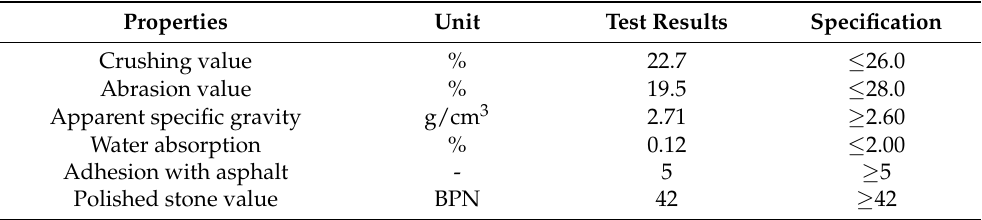
Figure 2. Structure of the low-temperature splitting test specimens. The lower layer was formed according to the Chinese specification for Standard Test Methods of Bitumen and Bituminous Mixtures for Highway Engineering (JTG E20-2011). The upper layer was made on the surface of the lower layer after it had been horizontally placed for 12 h. After demolding, each group of specimens was obtained. 2.2.2. Test Process The low-temperature splitting test was carried out on specimens with different UML thicknesses and control group specimens according to the Chinese specification for Standard Test Methods of Bitumen and Bituminous Mixtures for Highway Engineering (JTG E20-2011). Control group specimens were standard Marshall specimens formed at one time. All prepared specimens were frozen in a −10 °C low-temperature chamber for 24 h and then loaded with a multifunctional pavement material strength tester at a 1.0 mm/min loading rate. According to the maximum test load at which the specimens were damaged, the low-temperature splitting tensile strength of specimens was calculated using Equation (1). 𝑅 𝑇 = 0.006287𝑃 𝑇 ℎ